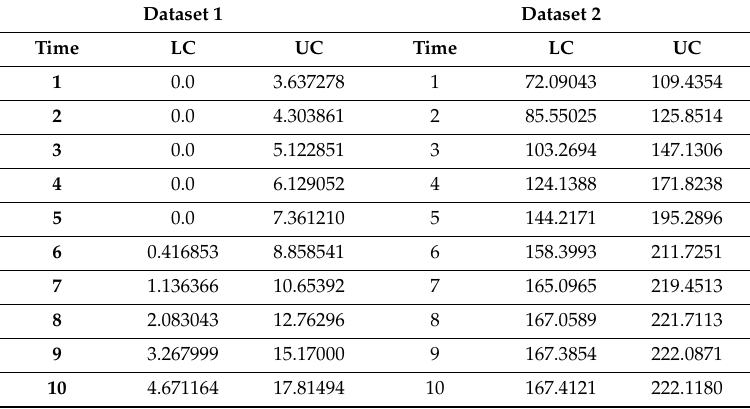
Table 8. Confidence intervals for datasets 1 and 2.